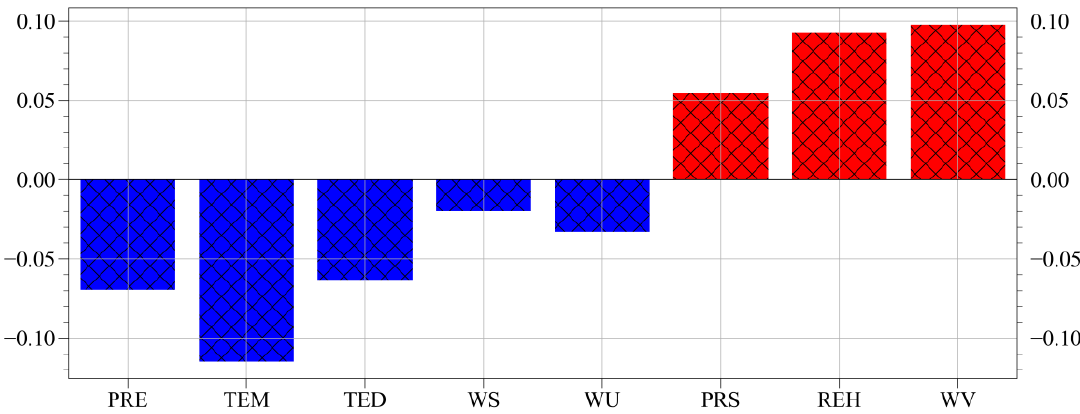
Figure 5. Overall correlation between PM 2.5 and meteorological factors.